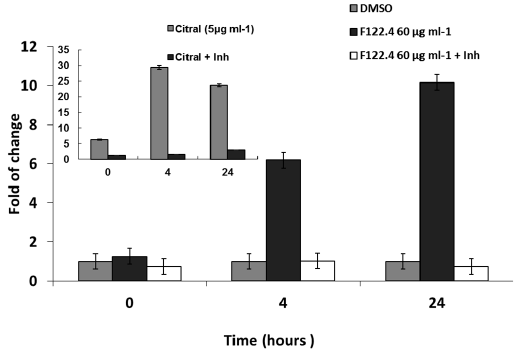
Figure 3. Induction of caspase-3 activity by A. graveolens fraction 122.4. 50–60 μ g/mL of